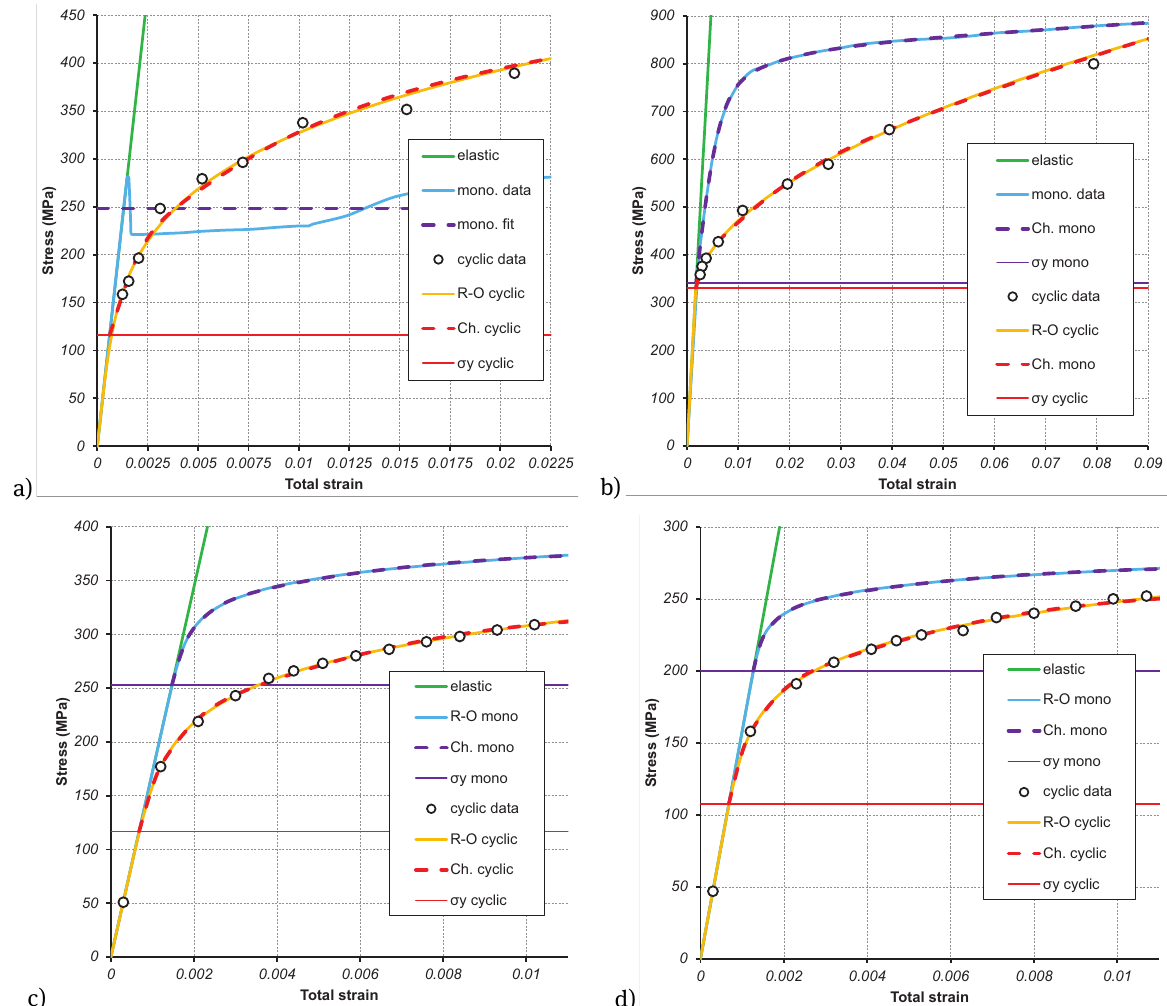
Figure 2: Fitting of monotonic and cyclic SSCs for: a) ASTM A36 steel from [21] at RT; b) AISI 4340 steel from [22] at RT c) ASTM P91 steel from [23] at 550 ◦ C and d) at 600 ◦